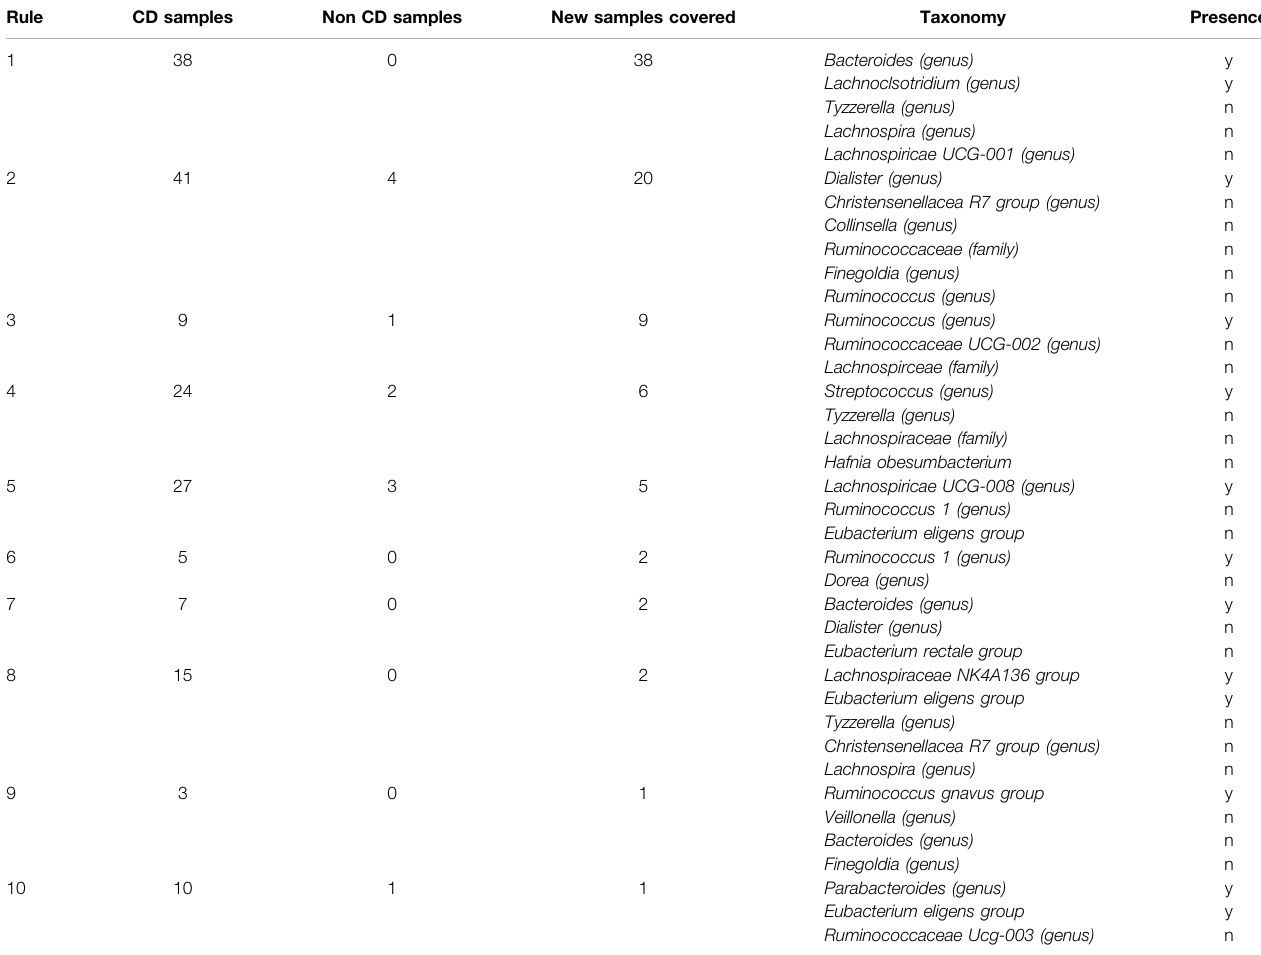
TABLE 2 | Association rules identi fi ed by BowSaw that account for all Crohn ’ s disease samples. Rule CD samples Non CD